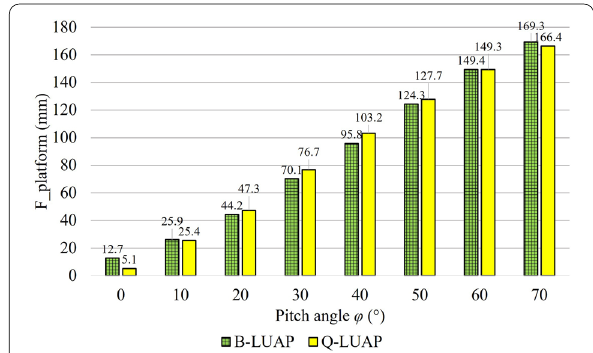
Figure 9 Platform height fluctuation comparison